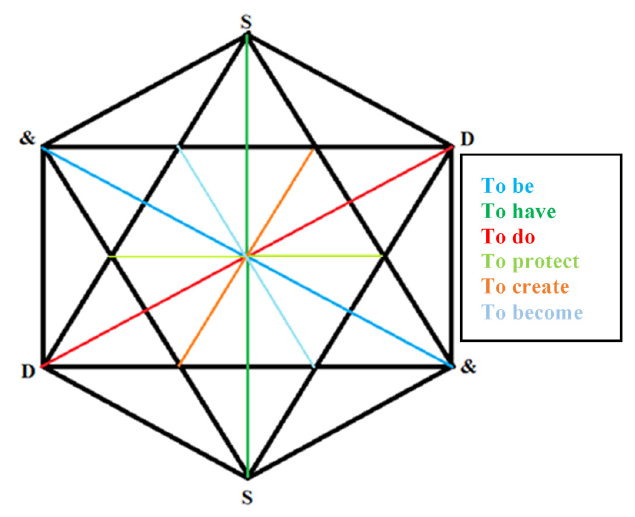
Figure 8. Semantical order of vectors in the fractalized model, containing: a source (S), a sensor (&), and a decident (D), authors source.